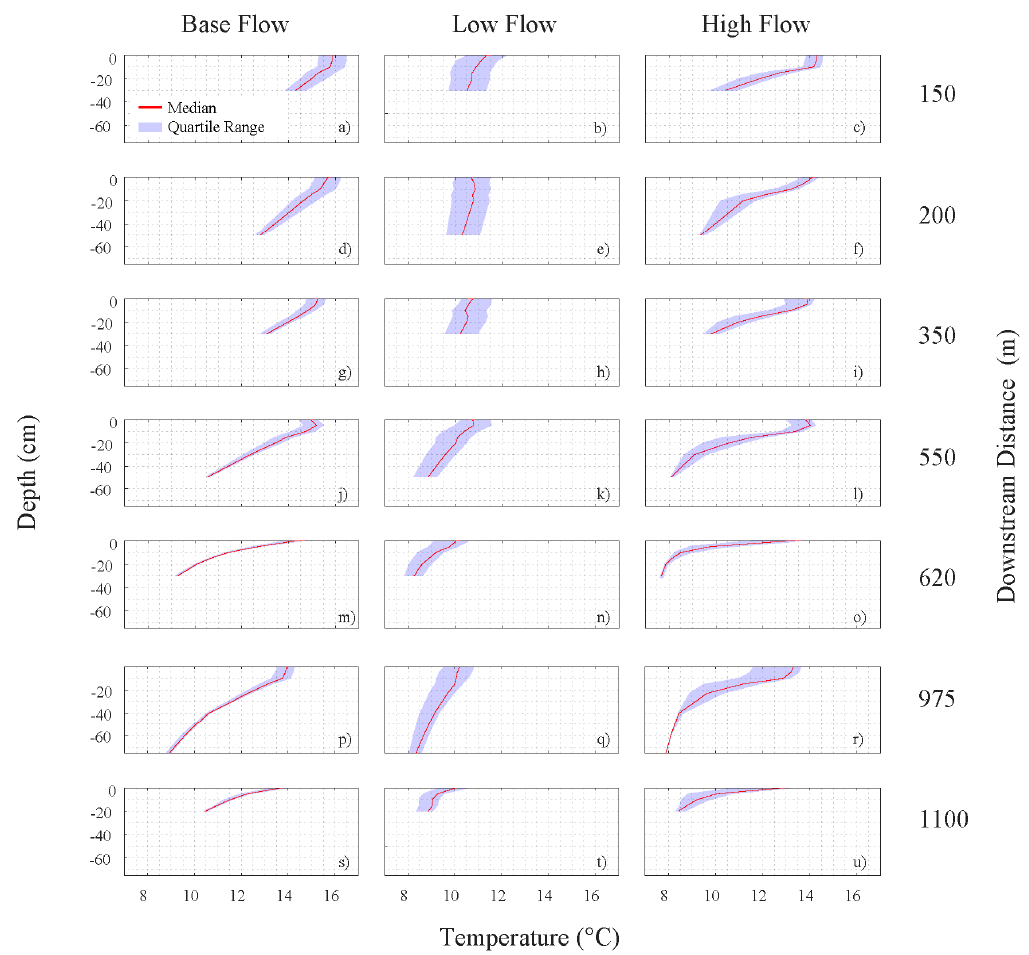
Figure 4. Vertical envelopes of temperature dynamics during base-, low-, and high-flow discharges at different monitoring locations. The envelopes indicate the interquartile range (shaded area) and the median (red line).